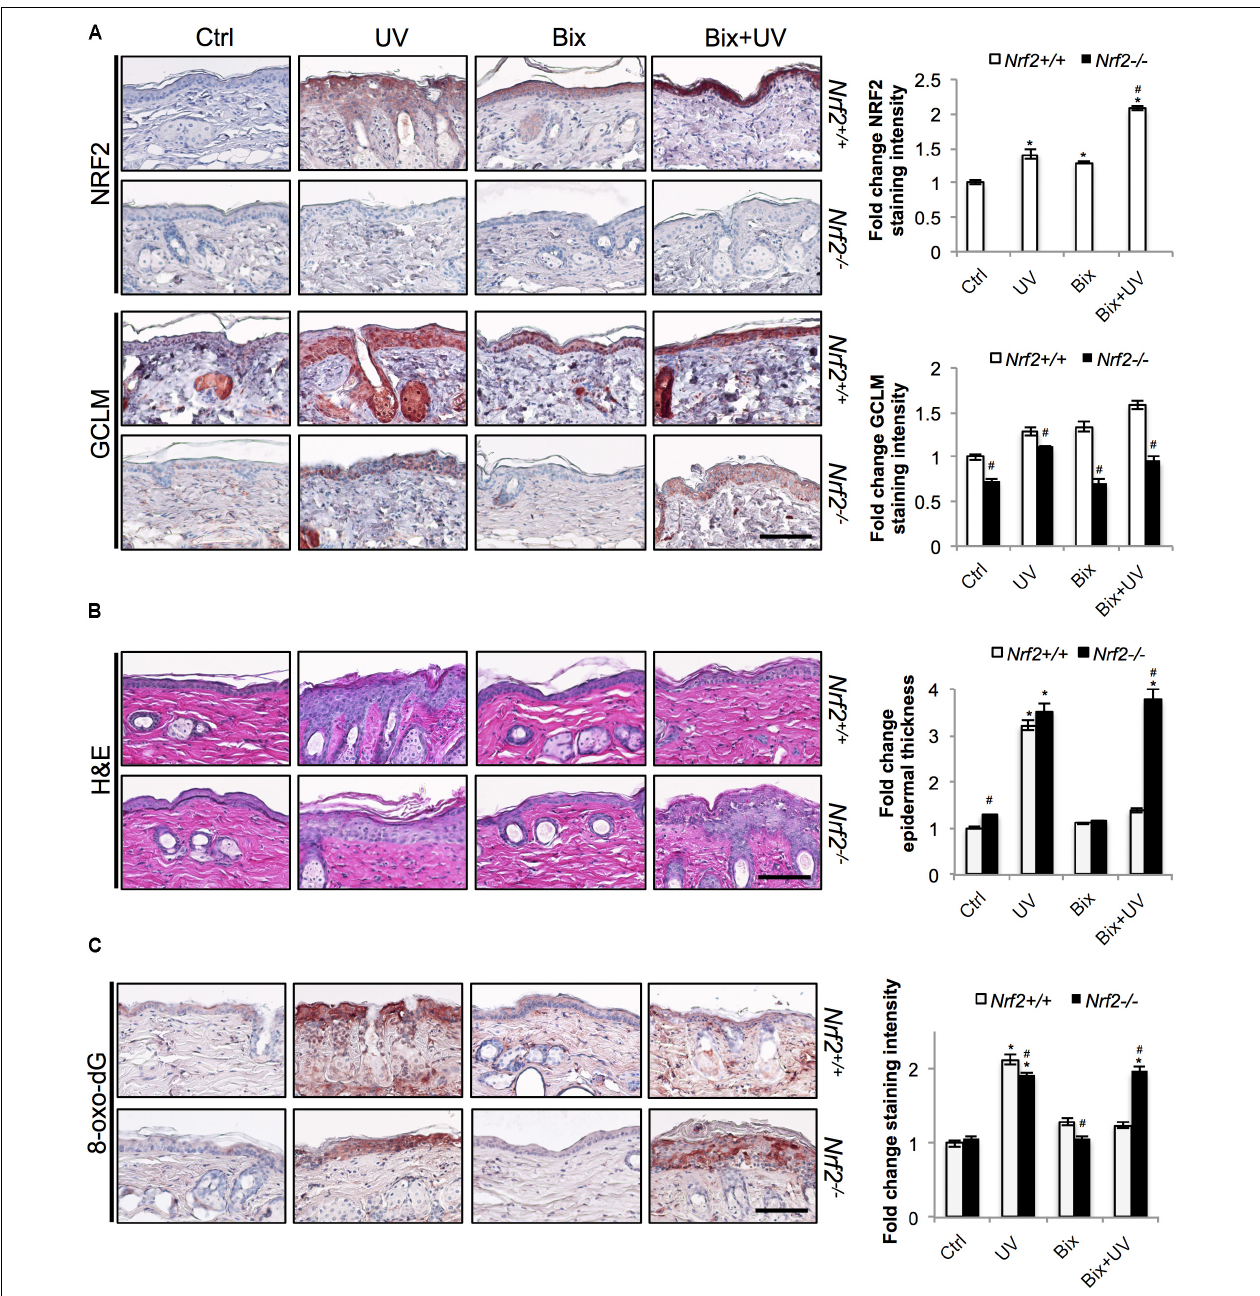
FIGURE 3 | Topical bixin protects SKH1 mouse skin against acute photodamage in an NRF2-dependent manner. Histological analyses were performed on skin tissue sections collected from the SKH1 Nrf2 + / + and Nrf2 − / − mice from the study depicted on scheme 1 ( Figure 2A ). (A) IHC staining of NRF2 and GCLM epidermal expression. (B) H&E staining. (C) Staining of the oxidative DNA damage marker 8-oxo-deoxyguanosine (8-oxo-dG). Representative images are shown. Scale bar: 10 µ m. Staining intensity was quantified, normalized, and represented as fold change compared to controls. p < 0.05: ∗ compared to Ctrl, # compared to Nrf2 + / +